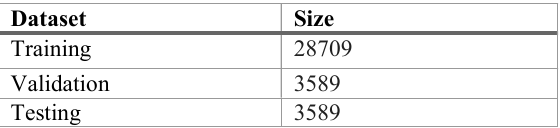
Table 3. Datasets description